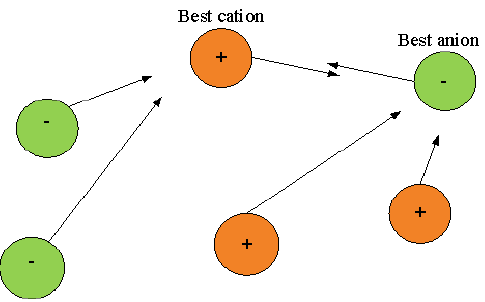
Fig. 2. Ions movement towards the best ions in the liquid